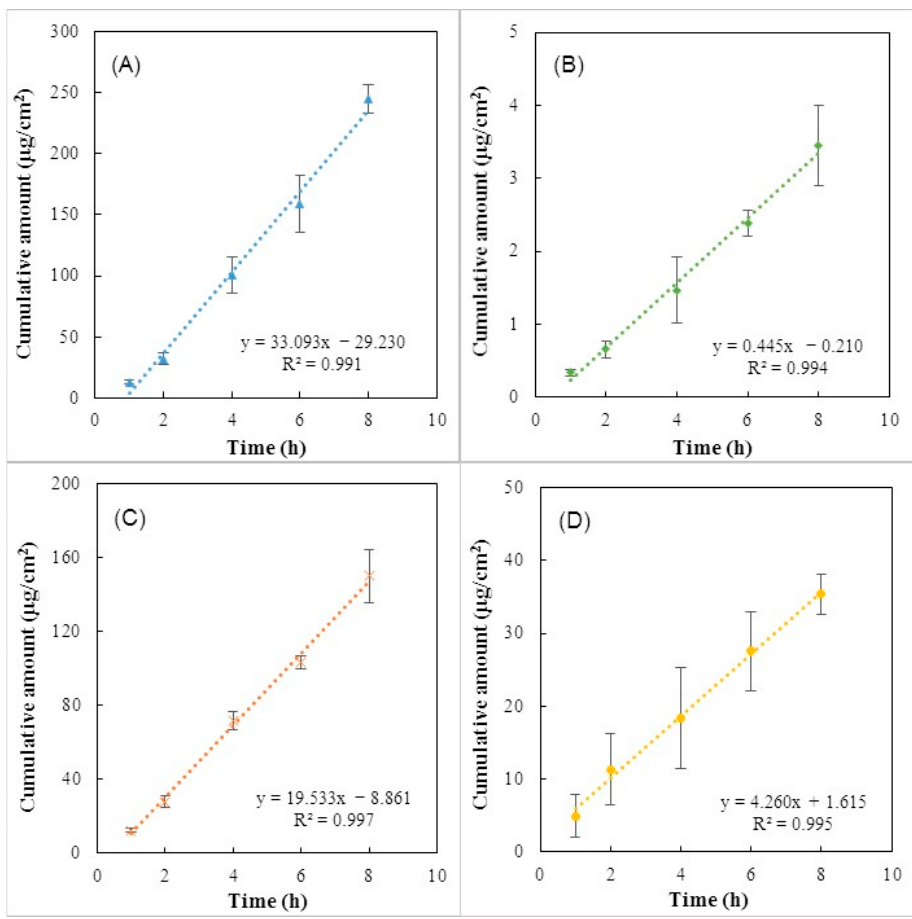
Figure 8. Cumulative amount profiles of ( A ) caffeine, ( B ) diclofenac sodium, ( C ) salicylic acid, and ( D ) ibuprofen sodium from Na5 1 * 4 hydrogels.